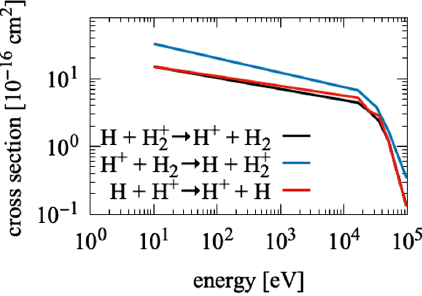
FIG. 3. Hydrogen charge exchange cross sections [80].